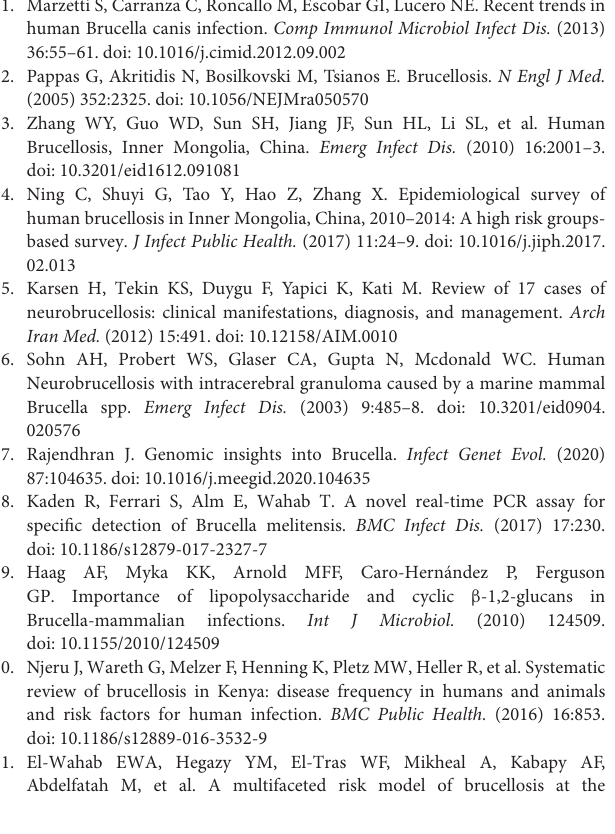
Supplementary Figure 1 | Analysis of Quantitative polymerase chain reaction (qPCR) the Brucella melitensis . Amplification curve of the qPCR confirmed the Brucella melitensis